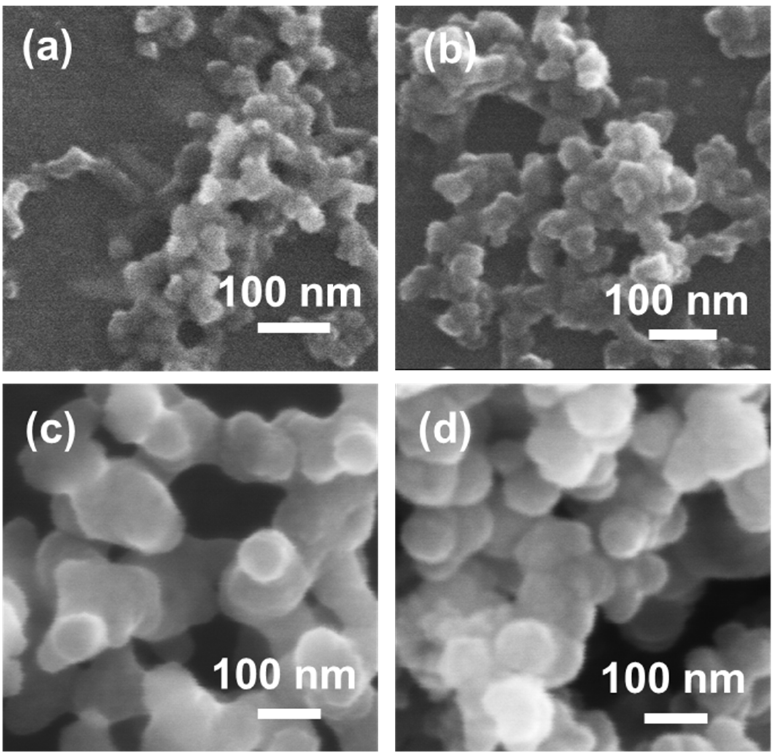
Figure 2. Scanning electron microscopy (SEM) images of ( a ) PLHA-V0, ( b ) PLHA-V50, ( c ) PLHA- V100, and ( d ) PLHA-V200.